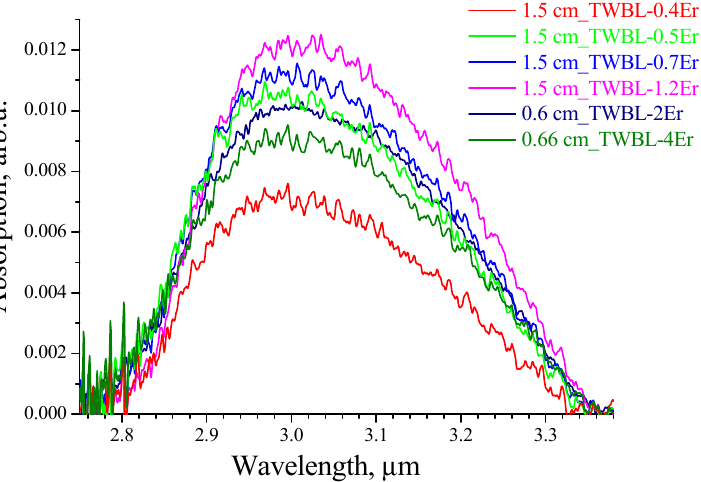
Figure 5. Absorption spectra of TeO 2 -WO 3 -Bi 2 O 3 -(4-x)La 2 O 3 -xEr 2 O 3 glass samples with different thicknesses within the hydroxyl groups band.